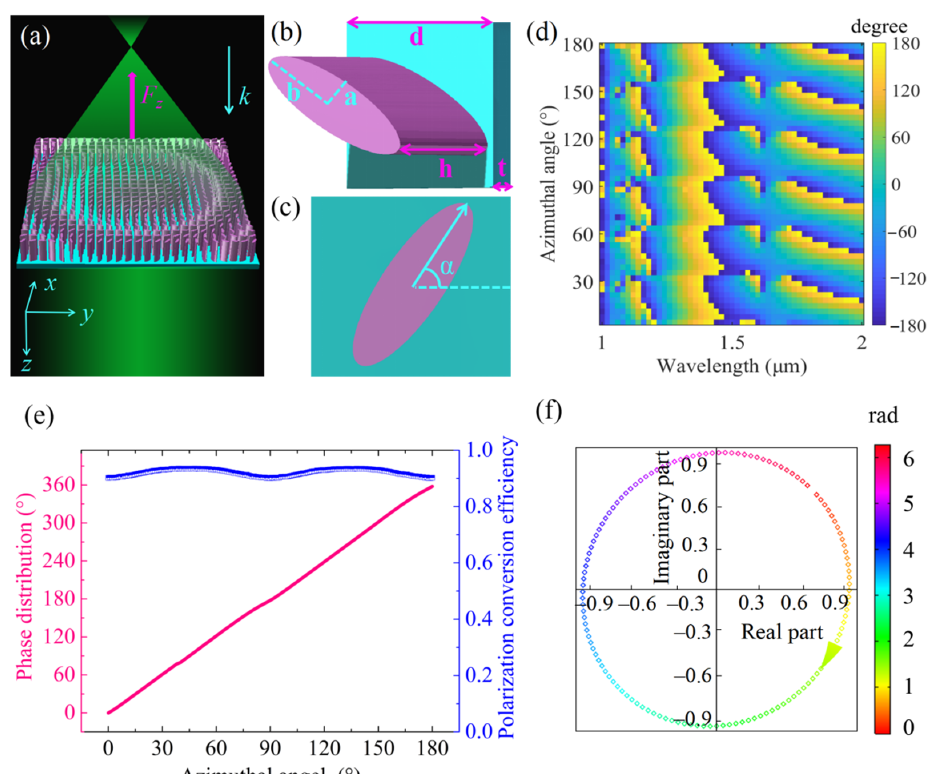
Figure 2. The design process of the metalens photonic probe. ( a ) Schematic of the metalens, where the output beam is steered by metalens to form a collimated beam. ( b , c ) Side and top view of a Si nanopillar on the silica substrate, one of the metalens building blocks. We arrange Si nanopillars in a square lattice. For the design wavelength λ = 1.817 μ m, the unit cell dimension is d = 0.8 μ m, the substrate thickness is t = 0.1 μ m, the nanopillar height is h = 1 μ m, the major axis is a = 0.35 μ m and the minor axis b = 0.1 μ m. ( d ) Simulated phase map φ ( α ) for the metalens designed at λ = 1.817 μ m. Each point shows the relative phase difference between a nanopillar and a reference point (the incident light propagates through the vacuum). ( e ) Polarization conversion efficiency (blue squares) and the phase distribution (pink line) of unit cell versus rotating angle α . ( f ) Complex transmission coefficients at the designed wavelength.